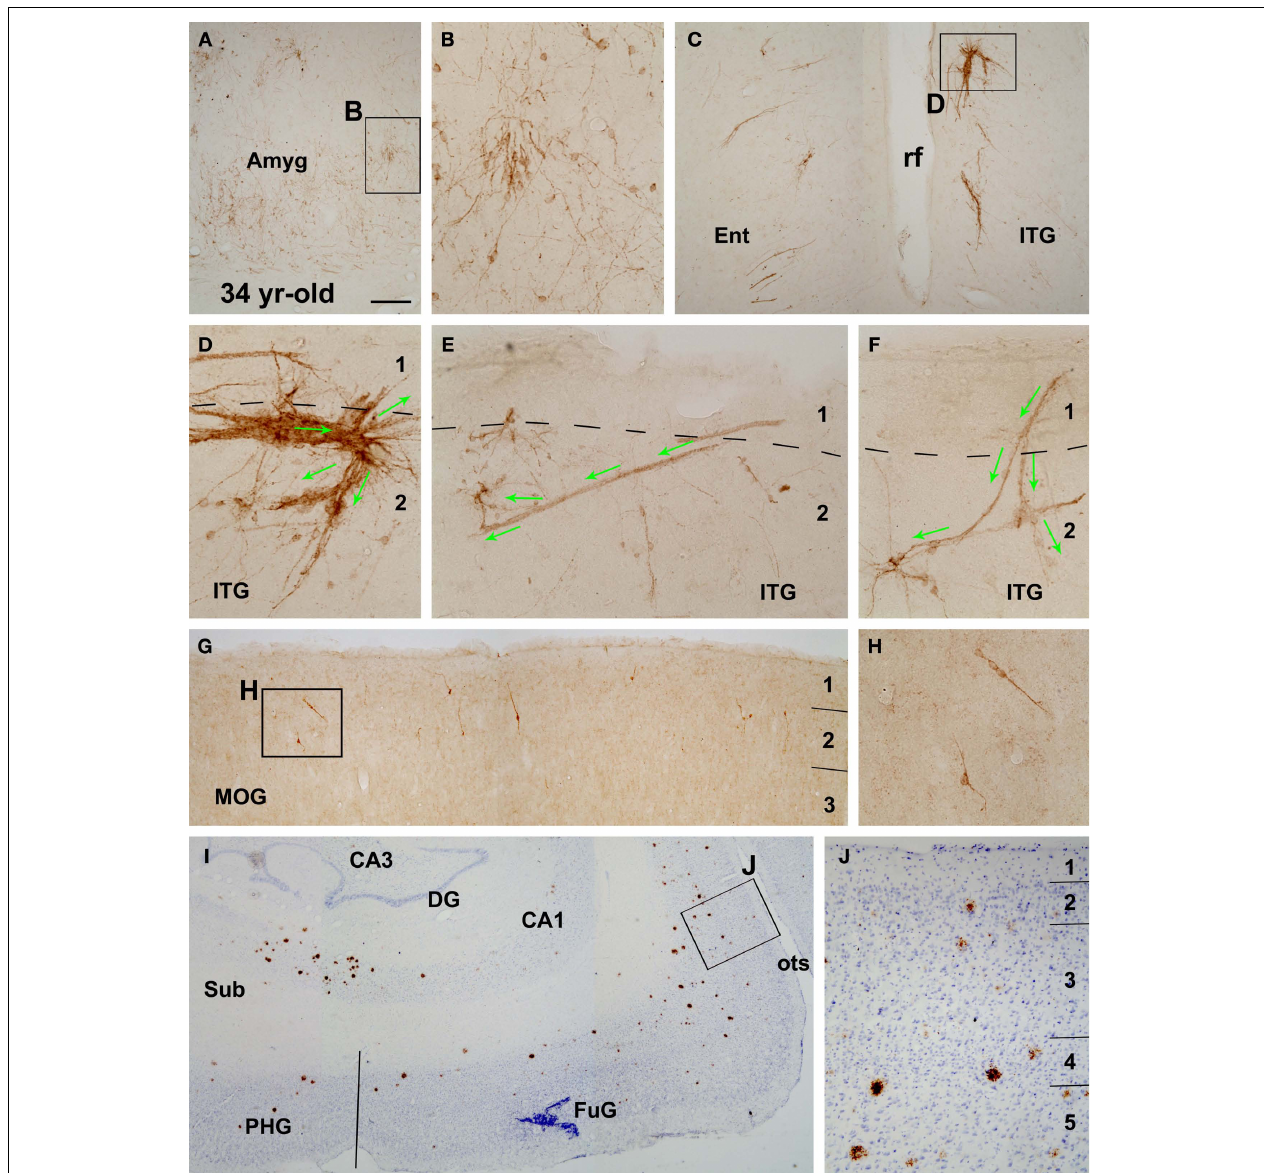
plaques around the hippocampal formation and temporal lobe structures is shown with 6E10 immunolabeling with Nissl counterstain (I,J) . Some plaques occur in layers II and III wherein DCX+ cells exist (J) . Sub, subiculum; PHG, parahippocampal gyrus, FuG, fusiform gyrus; opts, occipitotemporal sulcus. Other abbreviations are the same as in Figure 2 . Scale bar = 250 µm in (A) , equivalent to 500 µm for (I) , 150 µm for (C,G) , 100 µm for (J) and 50 µm for (B,D–F,H)